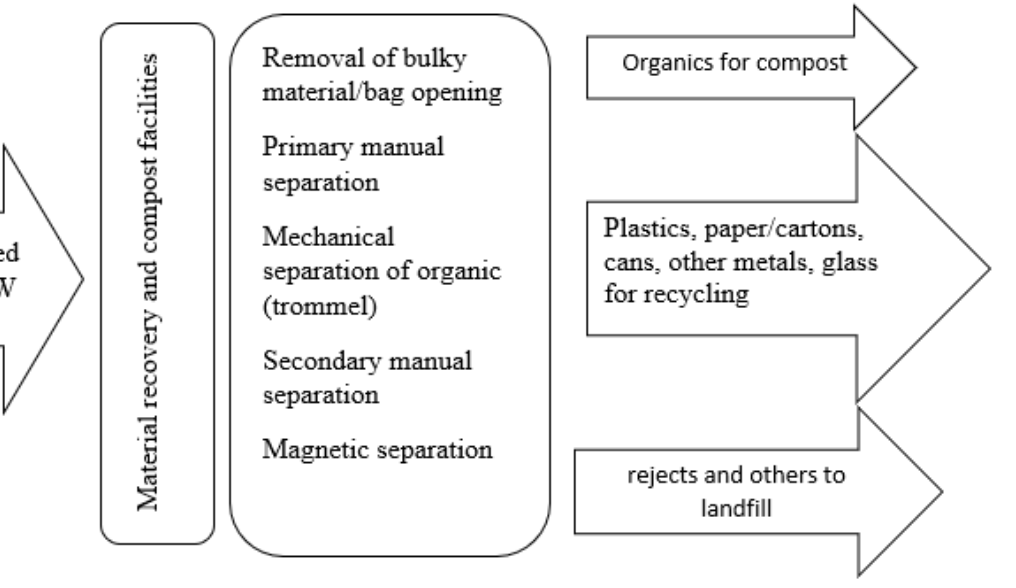
Figure 2. The general flow of the sorting process at the MRFs.